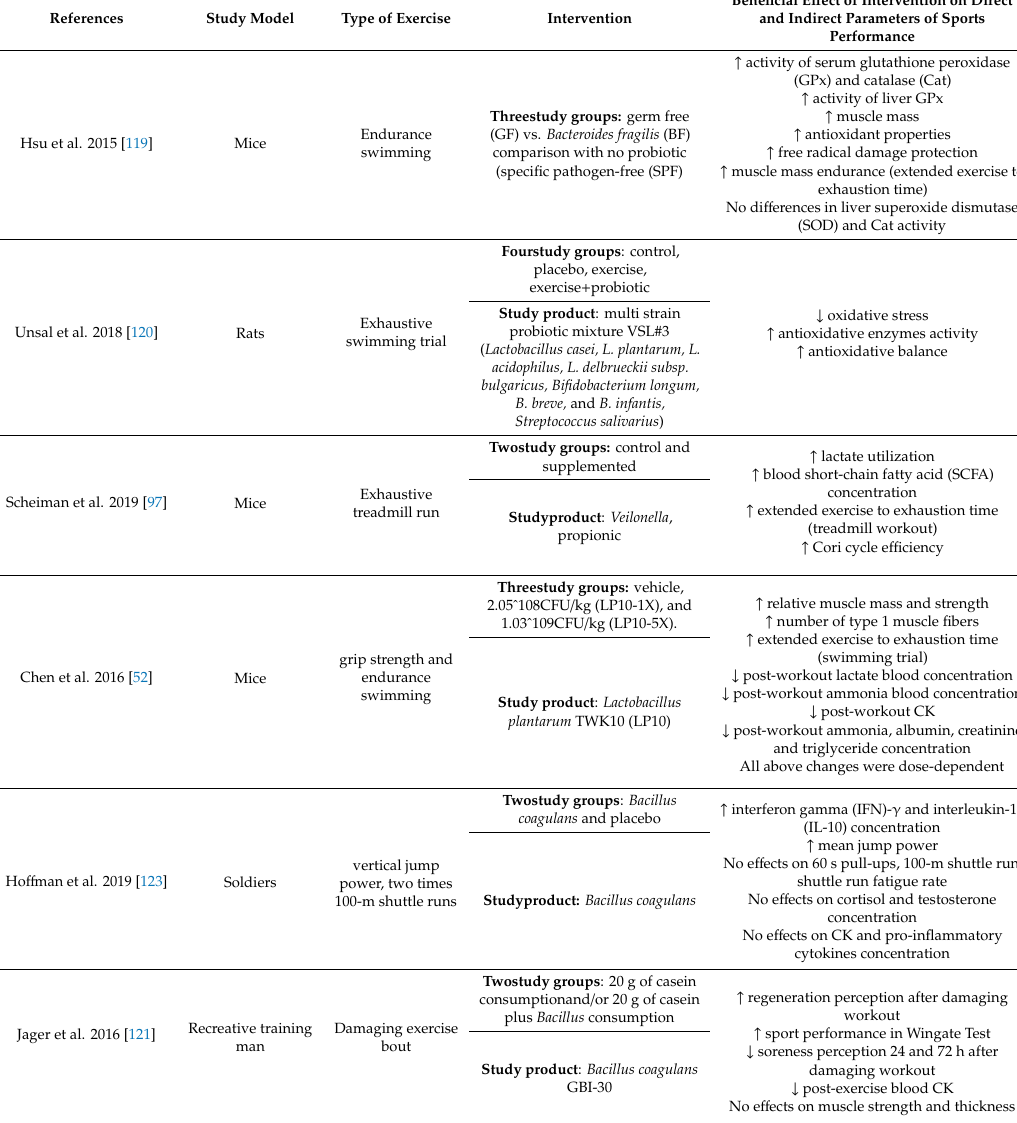
Table 1. The e ff ect of microbiota on